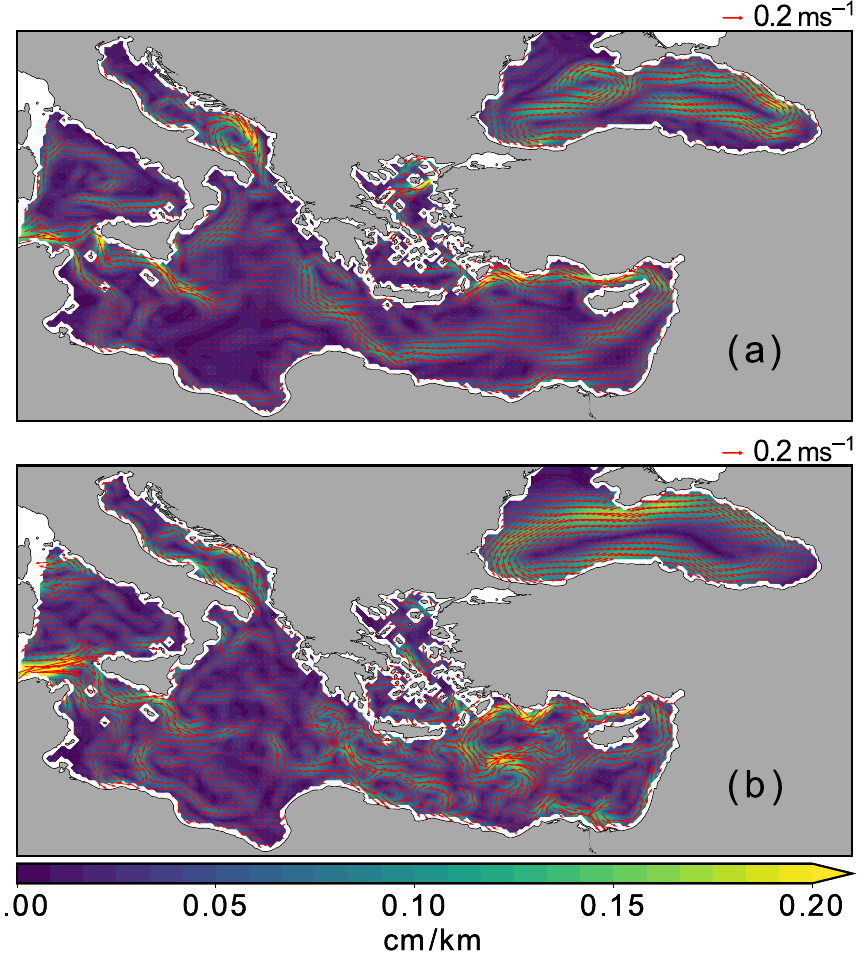
Figure 6. Horizontal gradient of surface elevation in cm · km − 1 , and barotropic component of geostrophic currents (red arrows), for the period 1985–2014. ( a ) EMBS simulation, and ( b ) AVISO satellite